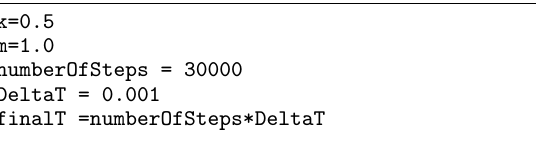
run much further, its deviations from the true solution will become so large as to be noticeable. Our numerical simulation is unstable in this